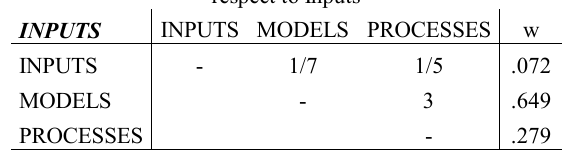
Table 2. Pairwise comparison of clusters with respect to Inputs